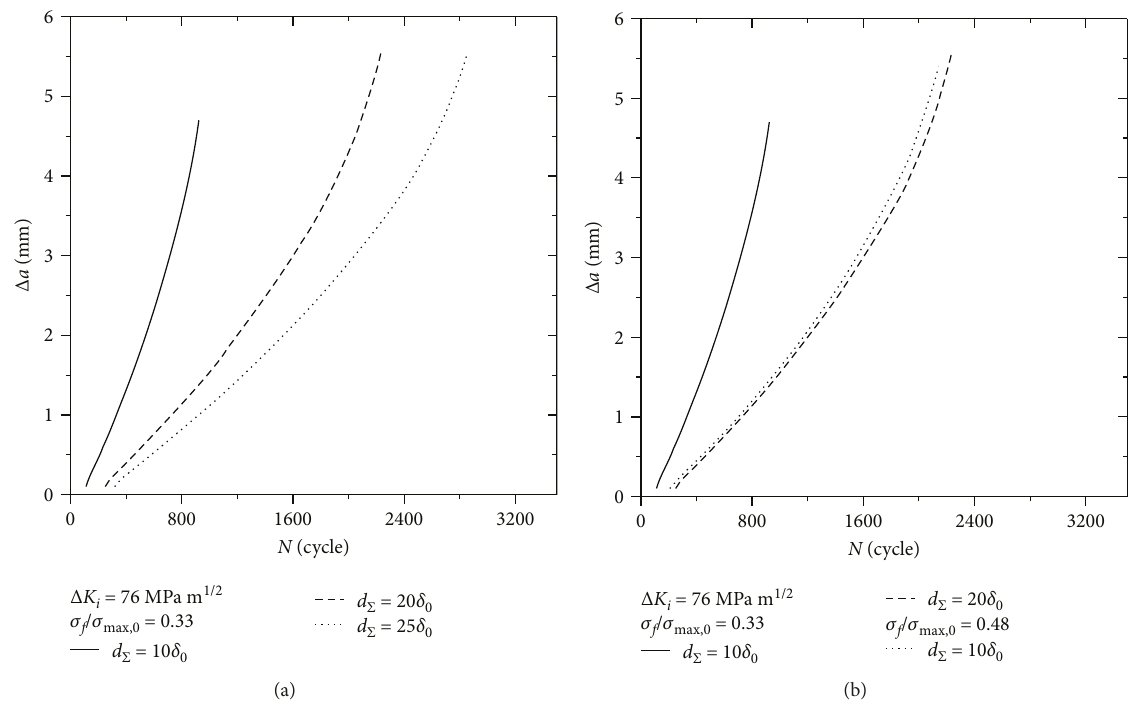
σ / σ Σ and (b) f max,0 on the crack growth curve. The constant loading amplitude is carried